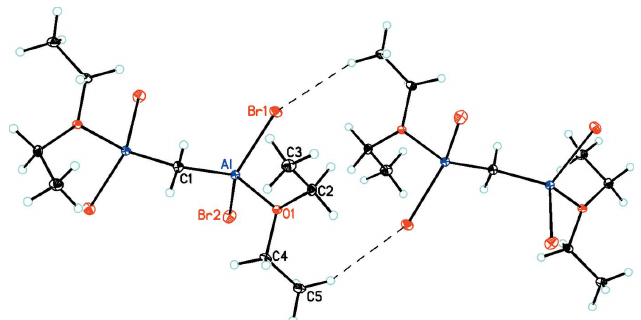
Figure 3 Diagram showing the C—H (cid:3)(cid:3)(cid:3) Br interactions (as dashed lines) that link the molecules into ribbons via the formation of R 2 operation, 1